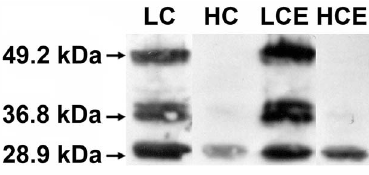
Figure 2. Immunoblot analysis of whole cell fractions from C. reinhardtii using a CAH3-specific antibody. Molecular mass markers are shown to the left. The four lanes (from left to right) are grown at: Low C i (LC), High C i (HC), Low C i + EE2 (LCE) and High C i + EE2 (HCE). doi:10.1371/journal.pone.0109289.g002 PLOS ONE |